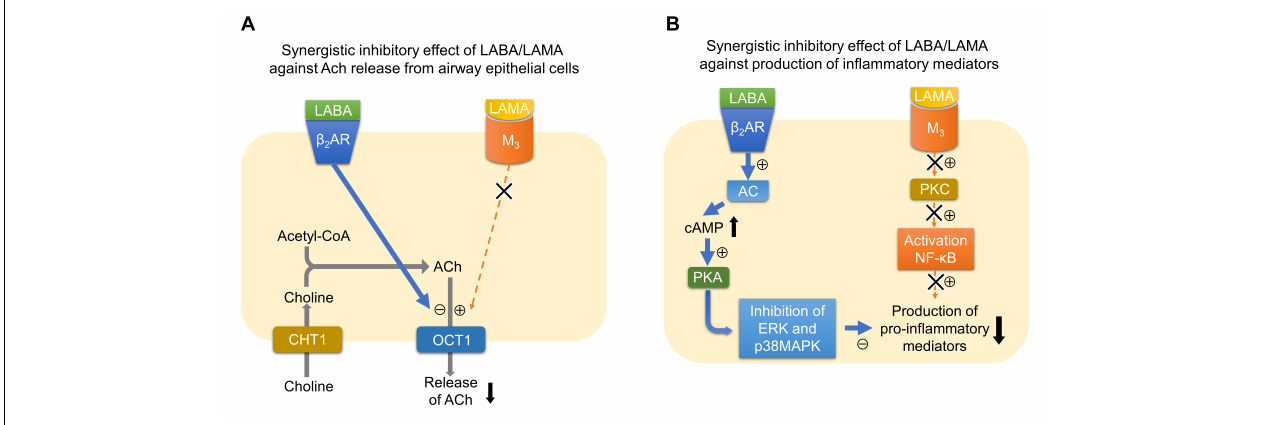
FIGURE 1 | Possible mechanisms of synergistic actions of the LABA/LAMA combination against inflammation. (A) Synergistic inhibitory effect of LABA/LAMA against ACh release from airway epithelial cells. Signaling via β 2 AR inhibits the function of OCT1, a transporter for the release of acetylcholine from airway epithelial cells, whereas signaling via M 3 possibly upregulates the function of OCT1. Therefore, the LABA/LAMA combination synergistically inhibits the release of ACh. (B) Synergistic inhibitory effect of LABA/LAMA against the production of inflammatory mediators. Signaling via β 2 AR activates AC-cAMP-PKA signaling pathway. PKA inhibits ERK and p38MAPK pathways. In contrast, signaling via M 3 activates PKC, which results in the activation of NF- κ B. The combination of LABA and LAMA therefore possibly inhibits the production of pro-inflammatory mediators synergistically via inhibiting both MAPK and NF- κ B pathways. ACh, acetylcholine; AC, adenylate cyclase; β 2 AR, beta-2 adrenergic receptor; cAMP, cyclic adenosine monophosphate; CHT1, high-affinity choline transporter 1; ERK, extracellular signal-regulated kinase; LABA, long-acting β 2 agonist; LAMA, long-acting muscarinic antagonist; MAPK, mitogen-activated protein kinase; M 3 , acetylcholine muscarinic M3 receptor; NF- κ B, nuclear factor-kappa B; OCT1, organic cationic transporter 1; PKA, protein kinase A; PKC, protein kinase